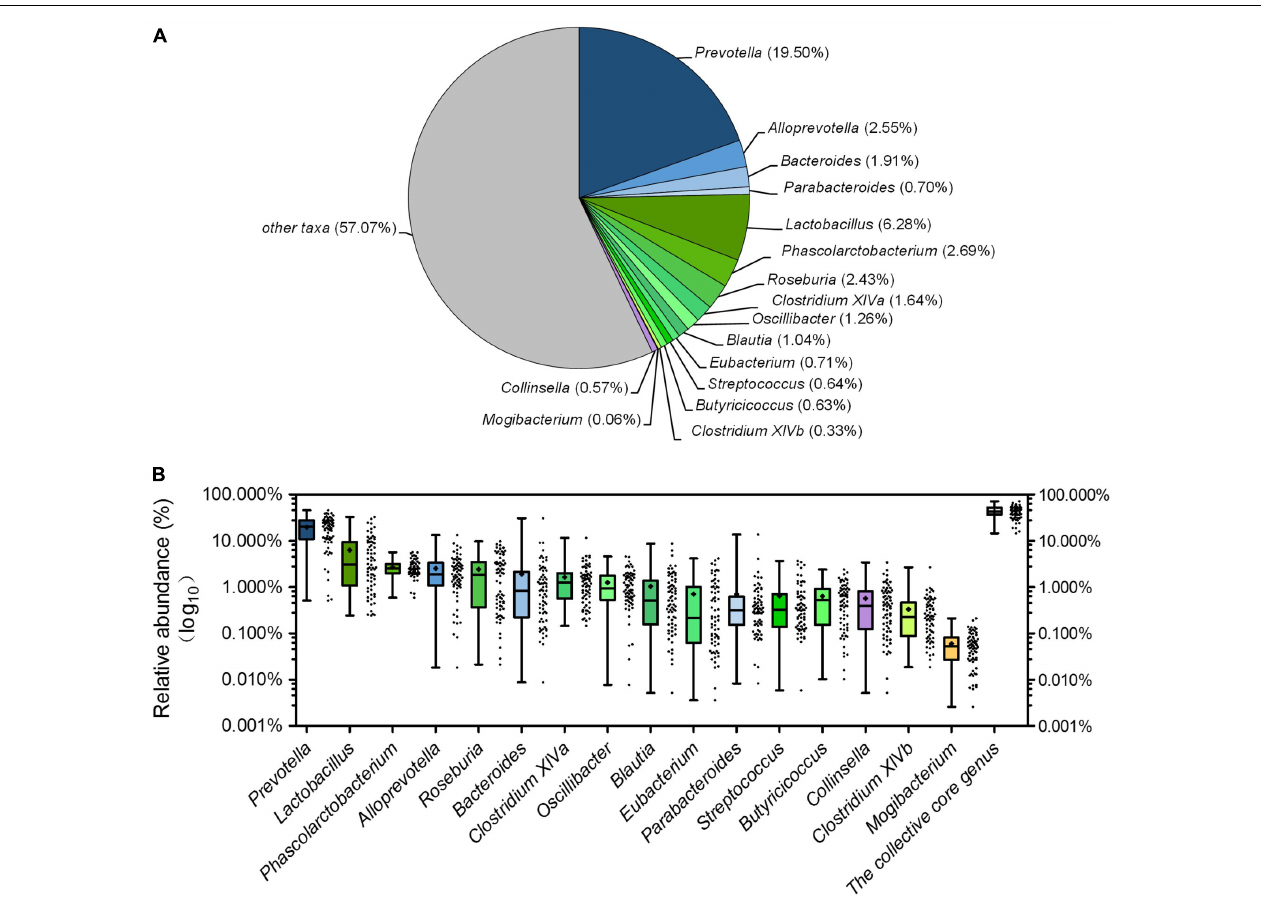
FIGURE 6 | The piglets share a core gut microbiota composed of 16 bacterial genera. (A) The proportion of each genus in the total sequences. (B) The abundance distribution of the 16 genera and the collective core. Boxes represent the interquartile range (IQR) between the first and third quartiles. The lines and spots inside boxes represent the median and mean, respectively. Whiskers denote the lowest and highest values within 1.5 × IQR from the first and third quartiles,